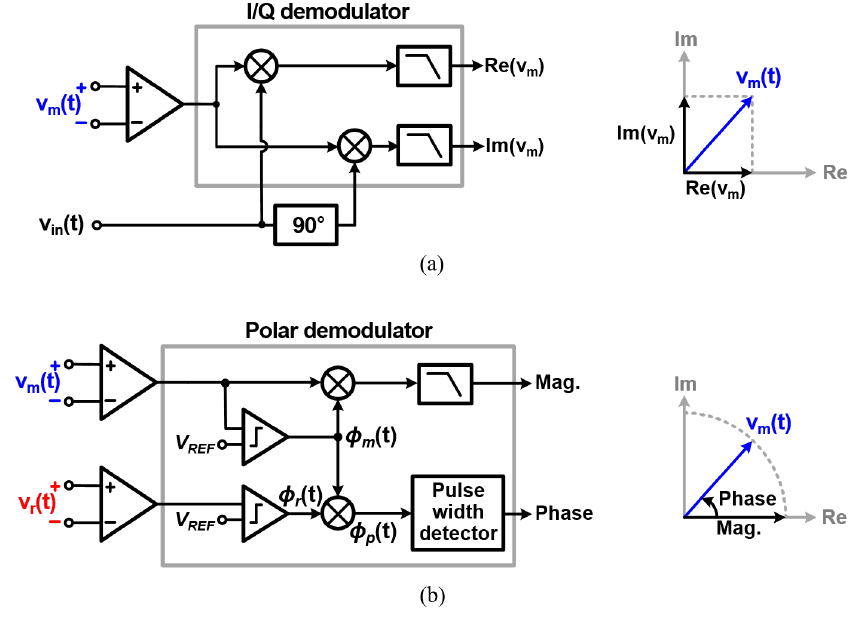
Figure 3. Representative structures of ( a ) the I/Q demodulator and ( b ) polar